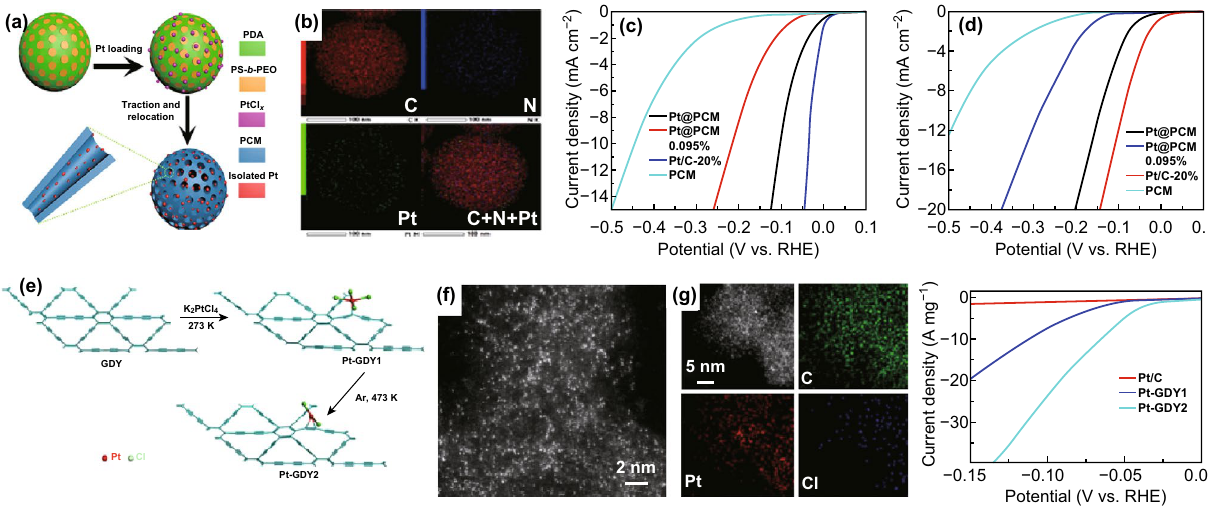
Fig. 12 a The synthetic process of Pt@PCM. b Element mapping images of Pt@PCM. Polarization curves of samples in c 0.5 M H 2 SO 4 and d 1.0 M KOH solutions. e The formation of Pt-GDY1 and Pt-GDY2. f AC-HAADF-STEM images for PtGDY2. g Elemental mapping for Pt- GDY2. (h) The polarization curves for Pt-GDY2, Pt-GDY1, and c Pt/C in acidic solution. a – d Reproduced under the terms of the CC-BY